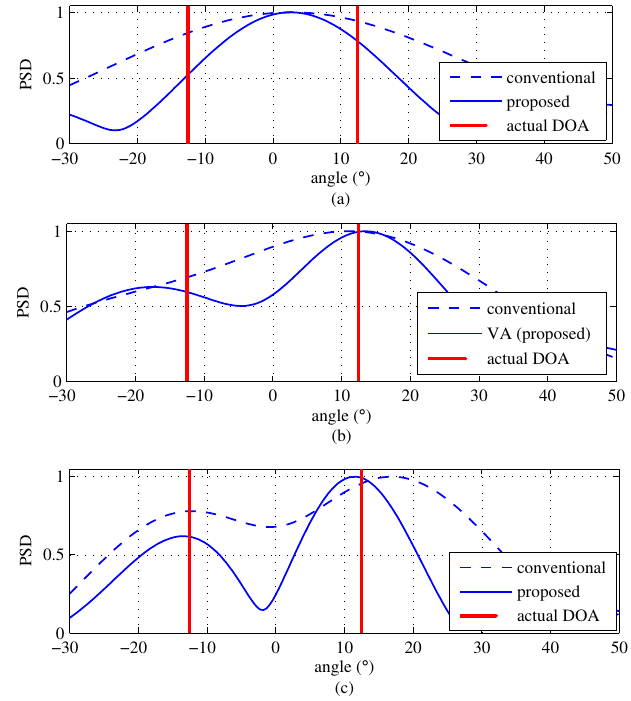
Figure 18. Experiment results with M = 2 ( θ 1 = − 12.6 ◦ , θ 2 = 12.6 ◦ ), ( a ) number of arrays K = 3; ( b ) number of arrays K = 4; ( c ) number of arrays K =